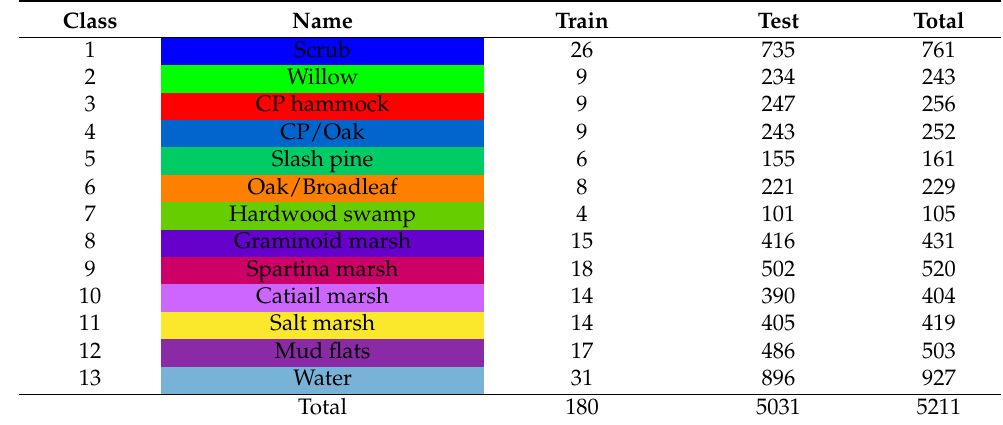
Table 3. Train-test distribution of samples for the Kennedy Space Center